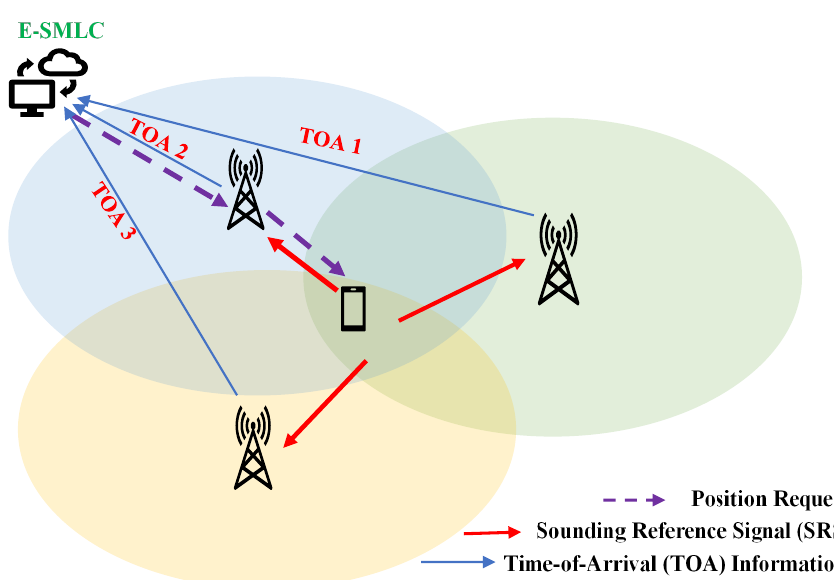
Figure 10. Signal transmission of conventional UTDOA